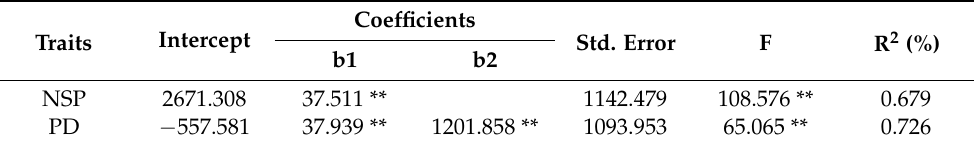
Table 6. Results of stepwise regression of grain yield per hectare as a dependent variable and other traits as the independent variables in the F8 population resulting from Gonbad × Kohdasht cross in 2021.